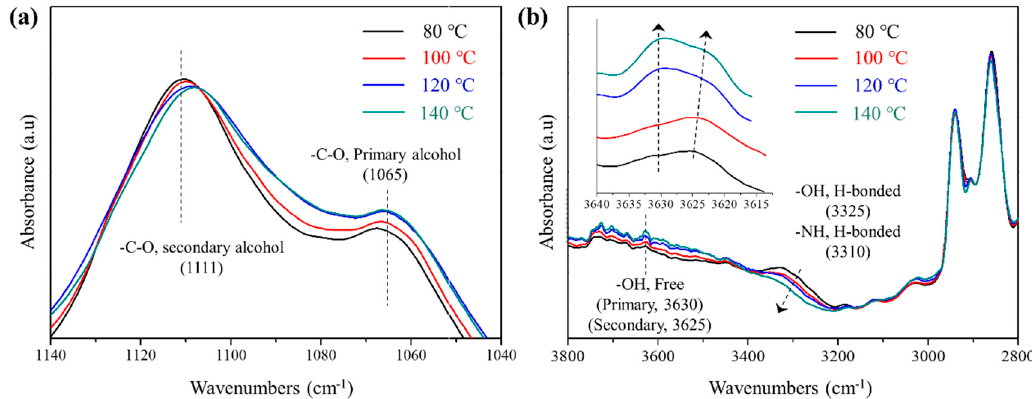
Figure 3. Temperature-dependent FT-IR spectra of S-PU: ( a ) at low wavenumbers (1140–1040 cm − 1 ); ( b ) at high wavenumbers (3800–2800 cm − 1 ).